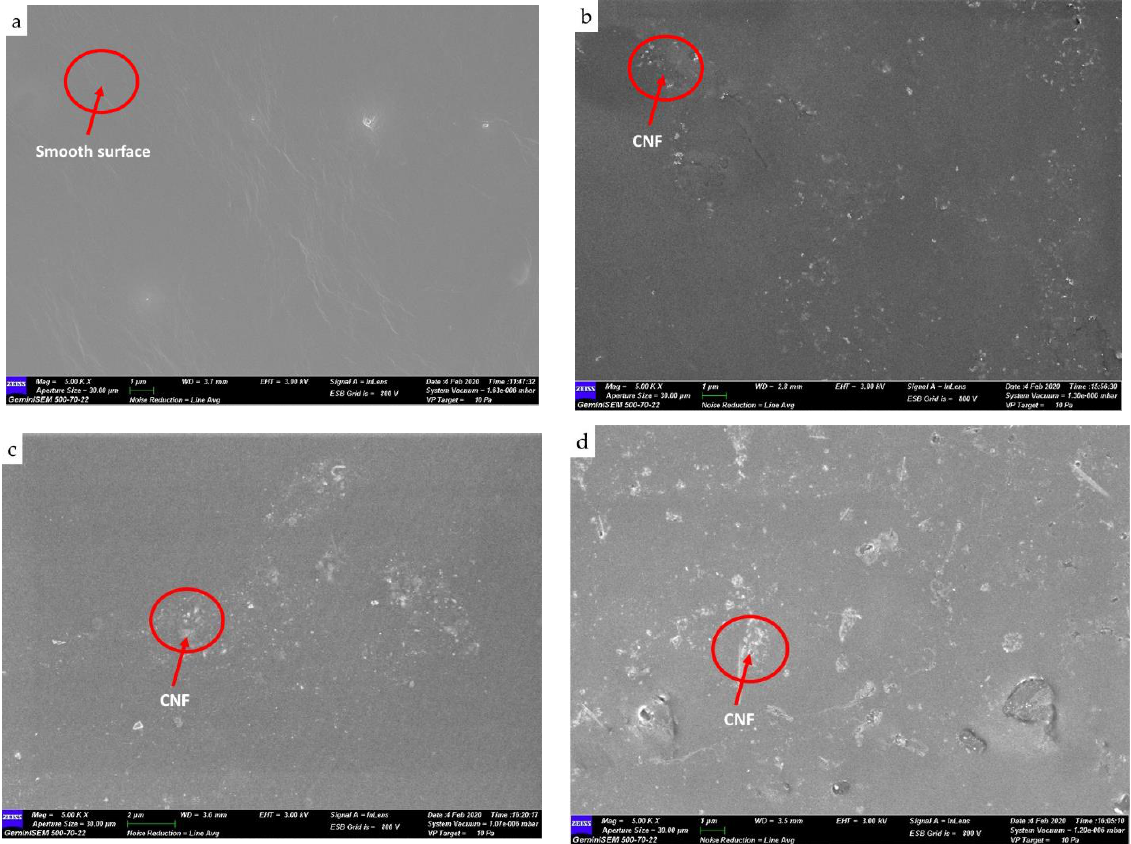
Figure 3. FESEM images of: ( a ) neat WBPU; ( b ) WBPU-0.1; ( c ) WBPU-0.25; ( d ) WBPU-0.5.